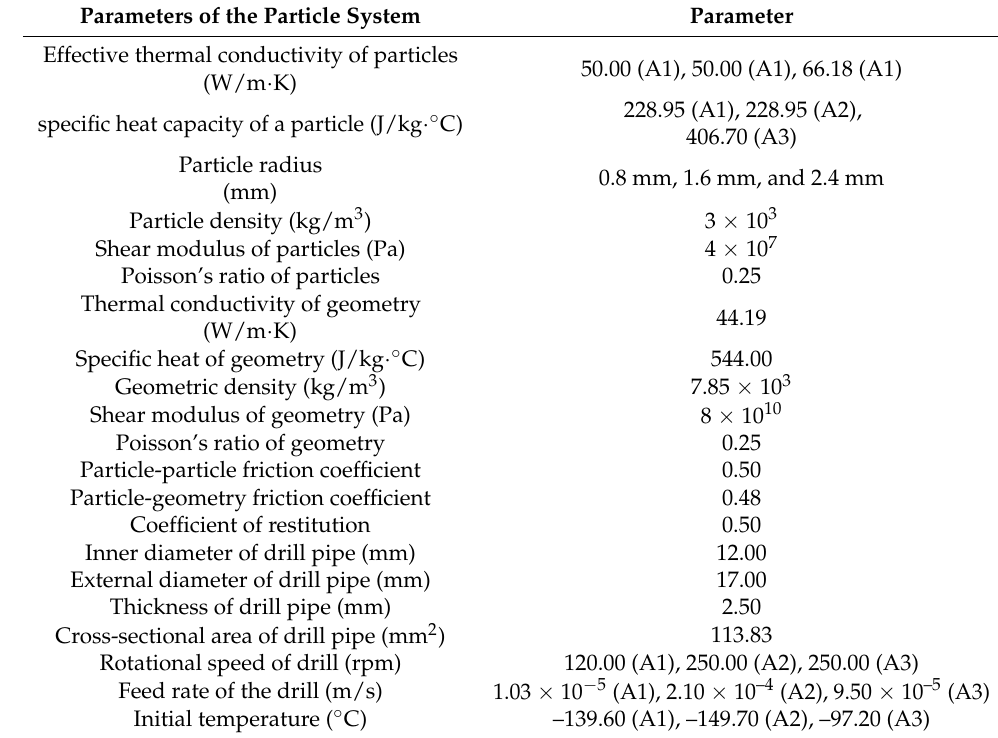
Figure 10. Drill bit temperature curve for No. A2 in experiment and simulation. Figure 11. Drill bit temperature curve for No. A3 in experiment and simulation.